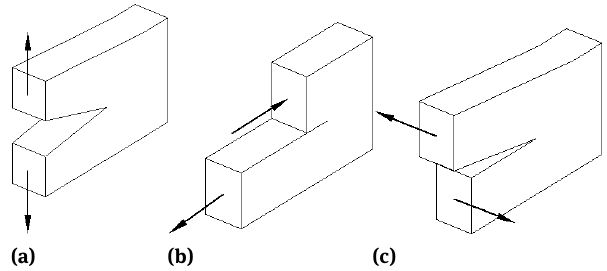
Figure 1: Three modes of loading for structural elements in structure mechanics: (a) mode I loading – crack opening; (b) mode II loading – in-plane shear; (c) mode III loading – anti-plane shear